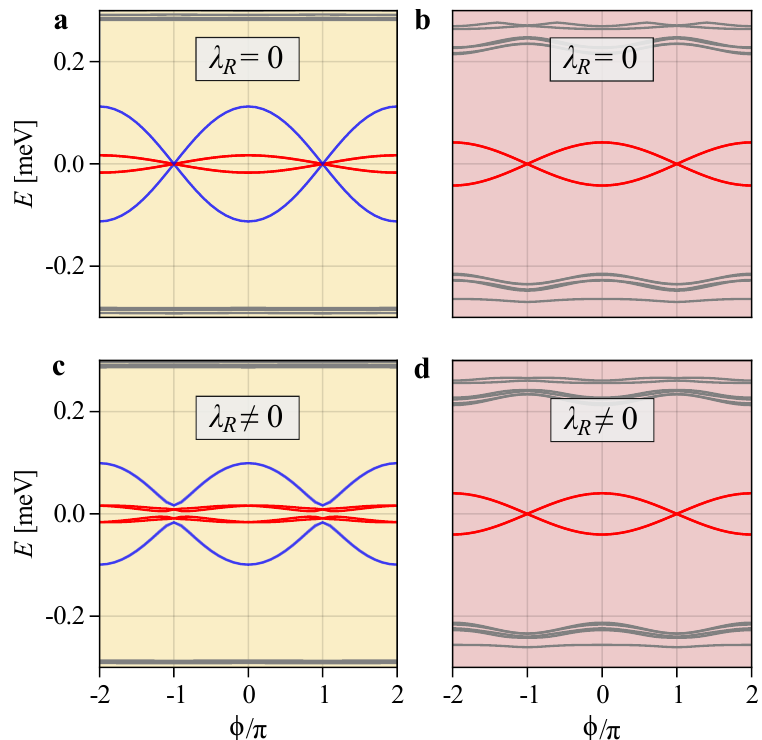
Figure 7: Andreev levels as a function of superconducting phase bias in a Josephson = 0 (a,b) and λ = 2 meV (c,d). The value of junction similar to Fig. 1(b), for λ R R E is fixed to the vertical dashed line of Fig. 5(b) (a,c) and Fig. 5(c) (b,d). The Z width of the junction is W = 2.5 µ m, but the length is shortened to L = 0.2 µ m to increase the phase-dependent MBS hybridization across the junction. Both the pairs of BDI-class MBSs in (a) and the lone D-class MBSs in (b) give rise to an approximate 4 π Josephson effect. Increasing λ breaks the BDI symmetry of (a), making the R Josephson effect from corner Majorana pairs (near-zero modes) 2 π -periodic, and hence trivial (c). The 4 π case of a single MBS per corner is however unaffected by Rashba